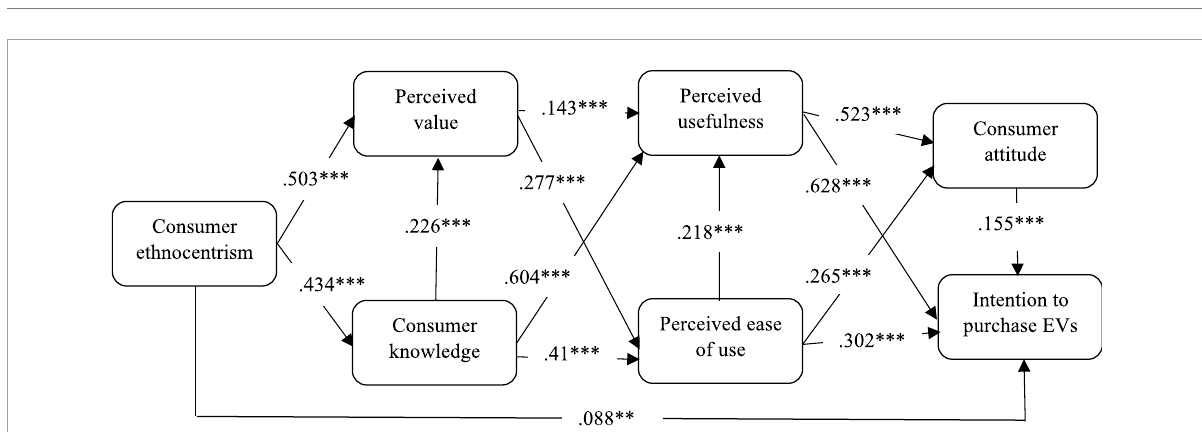
FIGURE2 The structural model outcomes. ∗∗ p < 0.01, ∗∗∗ p < 0.001, and critical ratio >